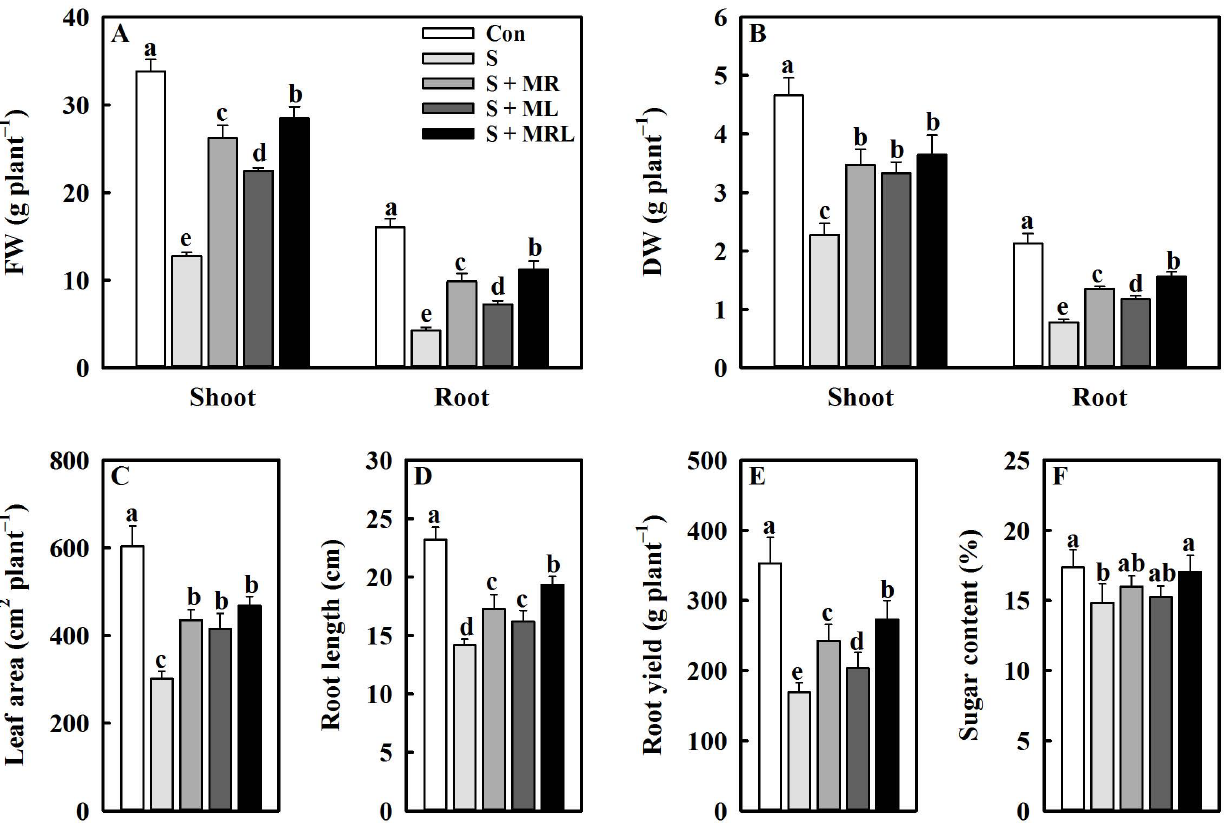
Figure 1. Effect of different methods of melatonin application on growth parameters and root yield and sugar content of sugar beets under salt stress conditions. ( A ) Fresh weight (FW) of shoots and roots, ( B ) dry weight (DW) of shoots and roots, ( C ) leaf area, ( D ) root length, ( E ) root yield, and ( F ) root sugar content. Con, control treatment; S, salt stress treatment; S + MR, salt stress treatment + root application of melatonin; S + ML, salt stress treatment + foliar application of melatonin; S + MRL, salt stress treatment + combined root and foliar applications of melatonin. Data show the means ± standard errors ( n = 4). Different letters indicate significant differences between treatments according to Duncan’s multiple range test ( p <